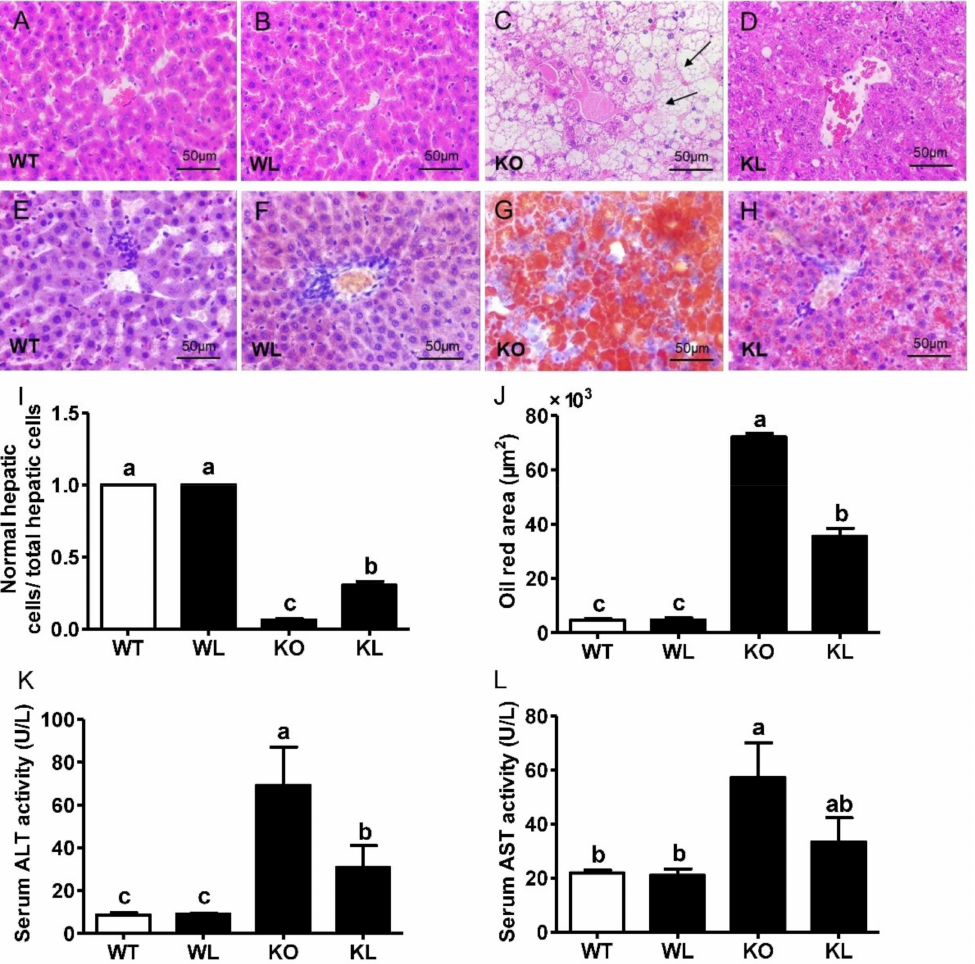
Figure 4. LWE ameliorated fatty liver formation in Lepr − / − rats. ( A – D ) Liver HE staining; ( E – H ) liver ORO staining; ( I ) ratio of normal hepatic cells to total liver cells (5 fields of view were randomly selected from each tissue section for statistical purposes); ( J ) oil red area of the liver; ( K ) serum ALT activity; ( L ) serum AST activity (n = 4–6). Columns with different letters are significantly different ( p < 0.05). black arrows present hepatic fatty